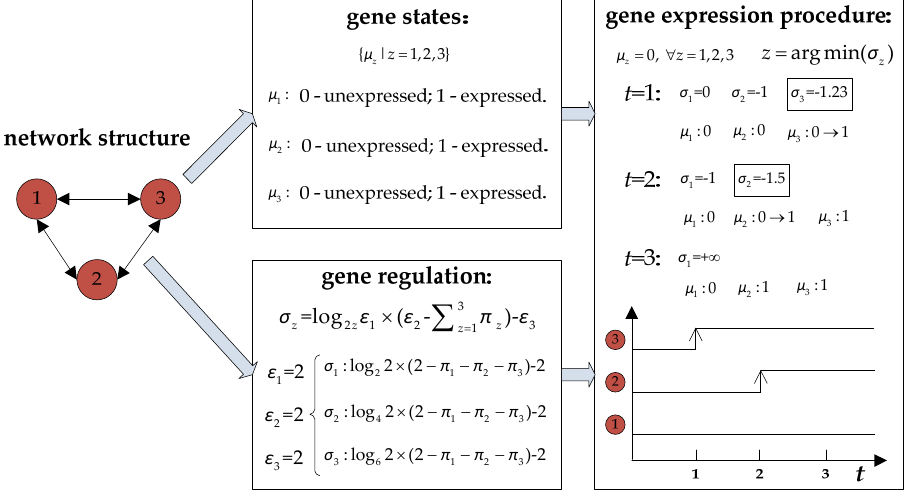
Figure 1. An example of GRN (Genetic Regulatory Network) composed of three genes.